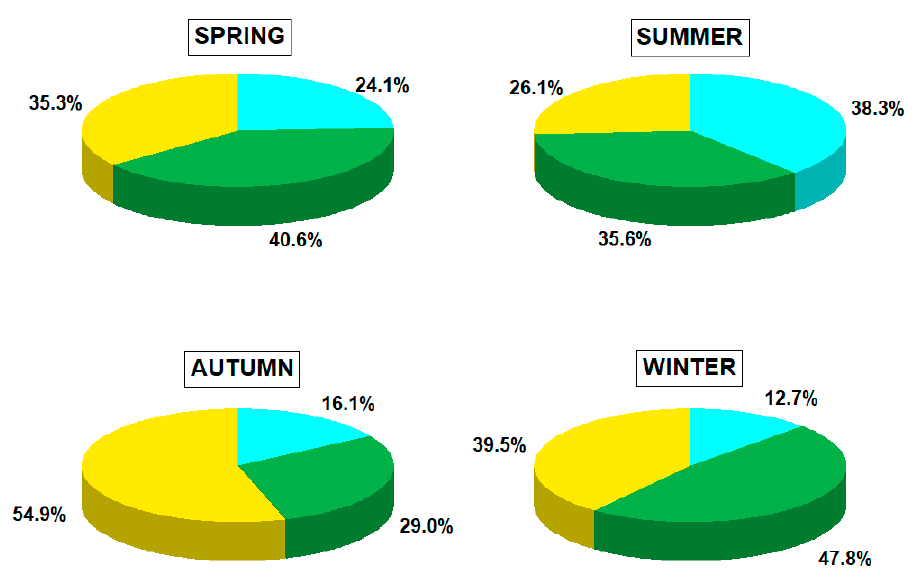
Figure 2. Pie-charts of low- (green), medium- (blue) and high-molecular-weight (yellow) PAH percentage share in total PAH deposition in four seasons.